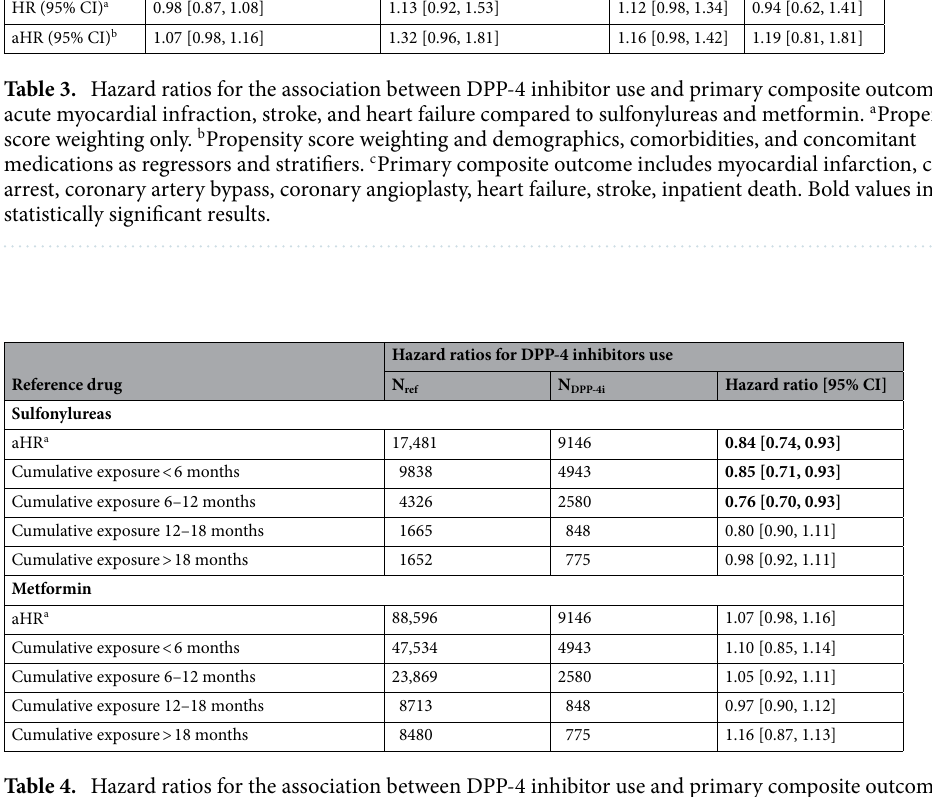
Table 4. Hazard ratios for the association between DPP-4 inhibitor use and primary composite outcome, stratified by cumulative exposure. Primary composite outcome includes myocardial infarction, cardiac arrest, coronary artery bypass, coronary angioplasty, heart failure, stroke, inpatient death. a Propensity score weighting and demographics, comorbidities, and concomitant medications as regressors and stratifiers. Bold values indicate statistically significant